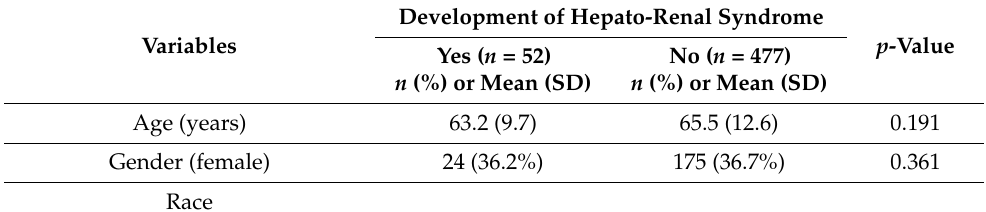
Table 2. Variables associated with the development of HRS in cirrhotic patients admitted with Acute Kidney